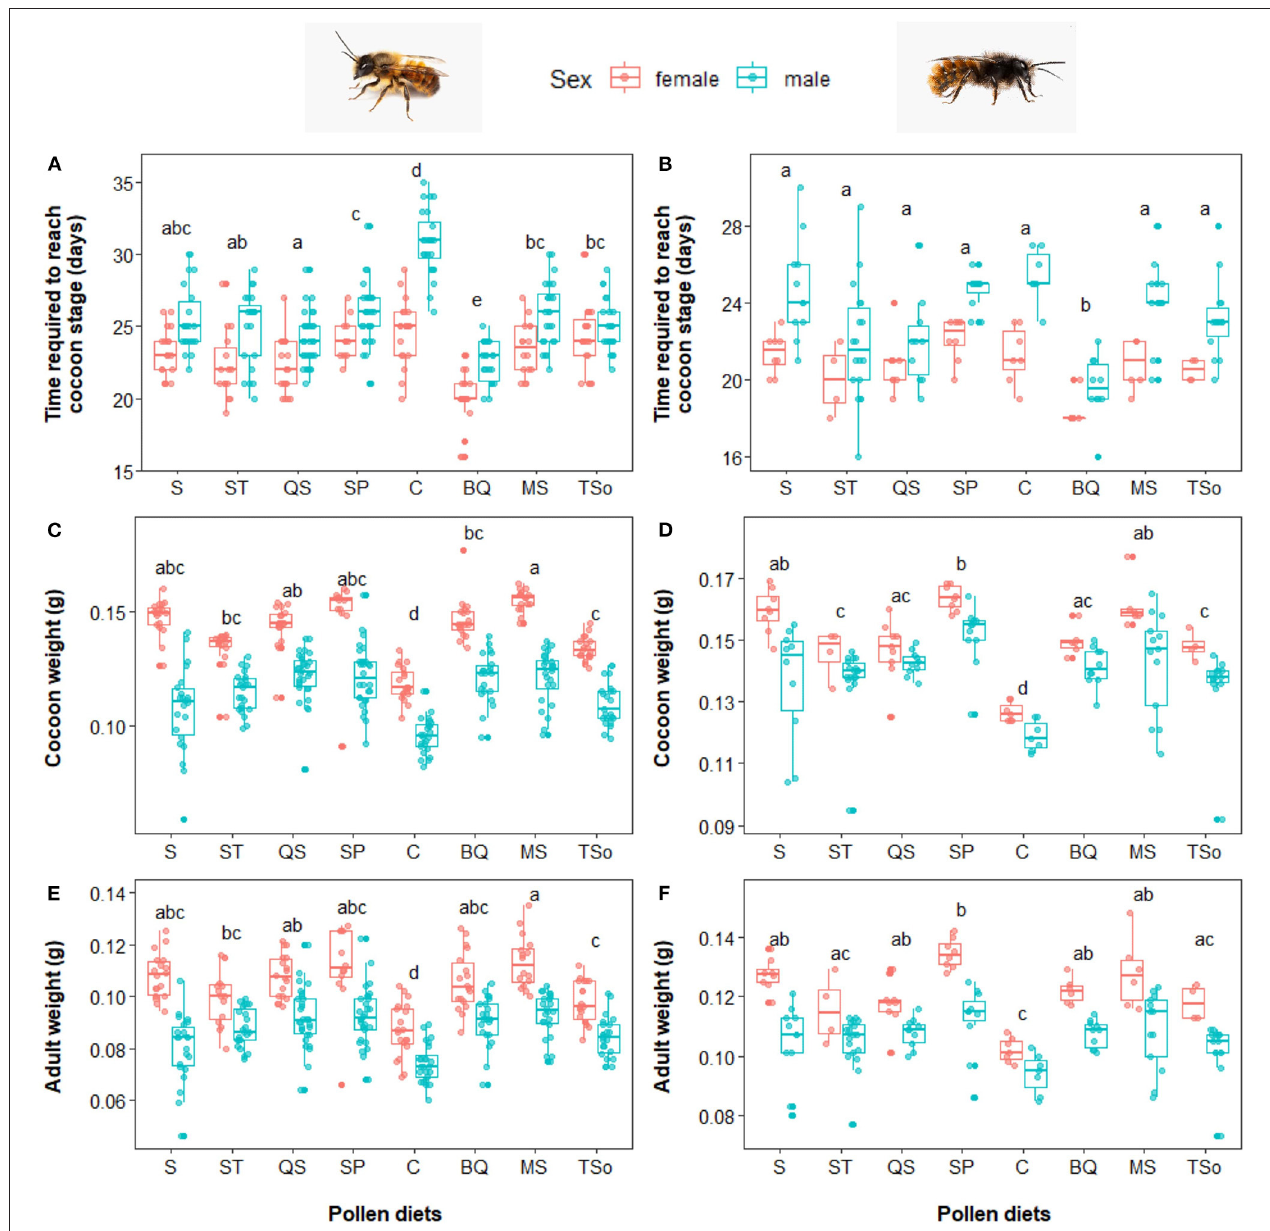
FIGURE 4 | Influence of pollen diets on (left) Osmia bicornis and (right) Osmia cornuta. (A,B) Time required for larvae to reach the cocoon stage (days), (C,D) cocoon weight (g) and (E,F) adult weight (g). Boxes indicate the 1st and 3rd interquartile range with line denoting median ( n = 40 per pollen diet). Different letters indicate significant differences between pollen diets (ANOVA tests followed by Tukey’s multiple comparison tests: p <